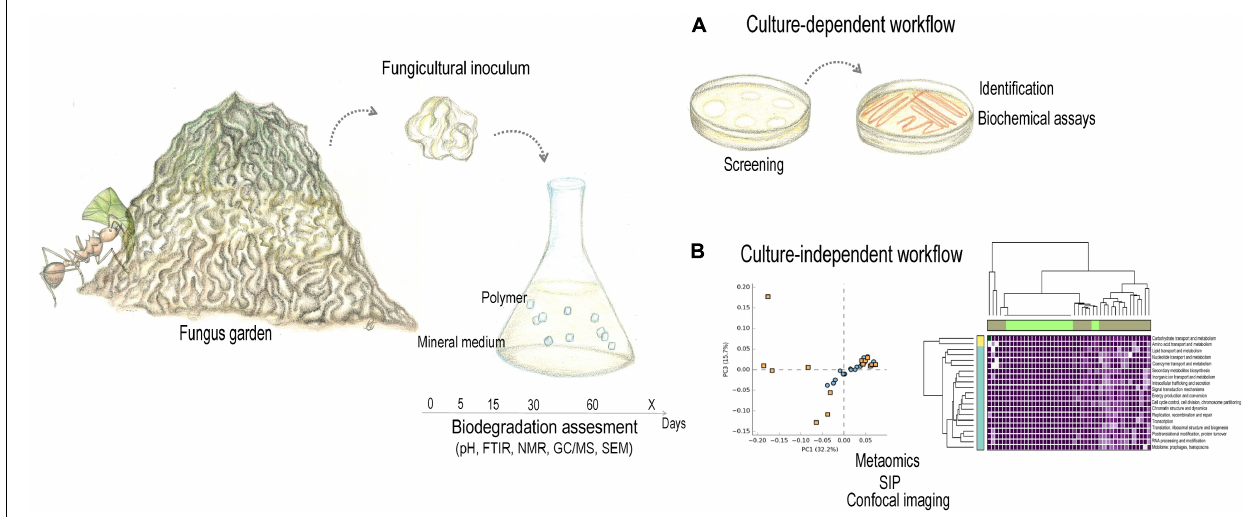
FIGURE 3 | Learning from symbioses. To take advantage of microbial flexible and adaptable metabolism, the characterization of both the taxa and the functional profile of the microbiota is required. Designing strategies for biotechnology becomes possible when knowing which microbes compose the community, how and when they interact to each other, and what are the outcomes of their biochemical communication. Using the attine ant fungus garden as example, samples from insect fungiculture environment could compose the initial inoculum for degradation assays, performed through interconnected (A) culture-dependent and (B) culture-independent workflows. This would allow invetigating the metabolic potential of the associated microbiota without threatening insect populations. Pencil drawing illustrations by Mariana Barcoto. PCA and heatmap were set up using random annotations, and do not comprise actual